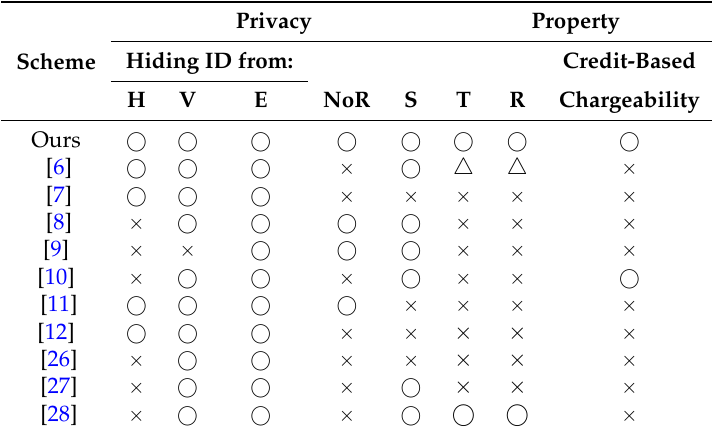
Table 1. Comparisons.